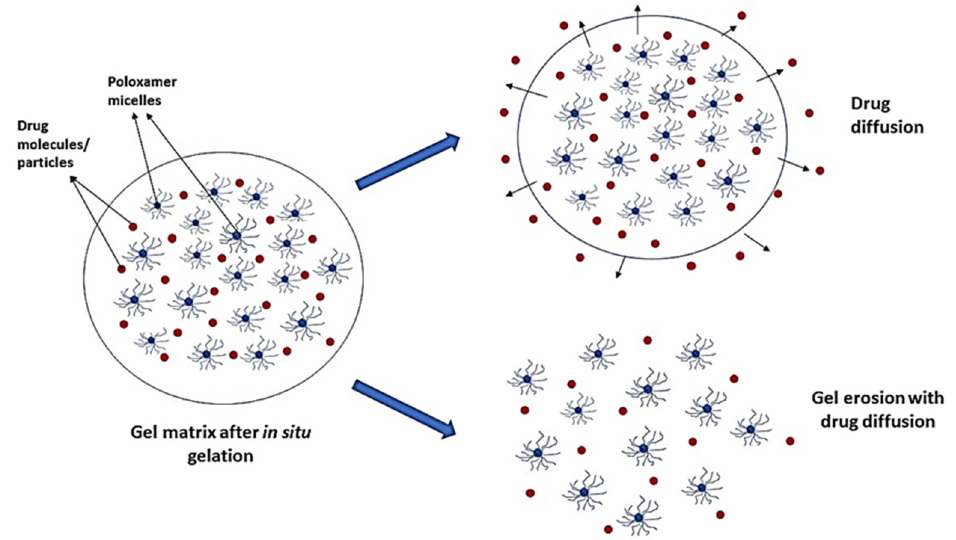
Figure 4 . Drug release mechanisms from thermosensitive in situ gels